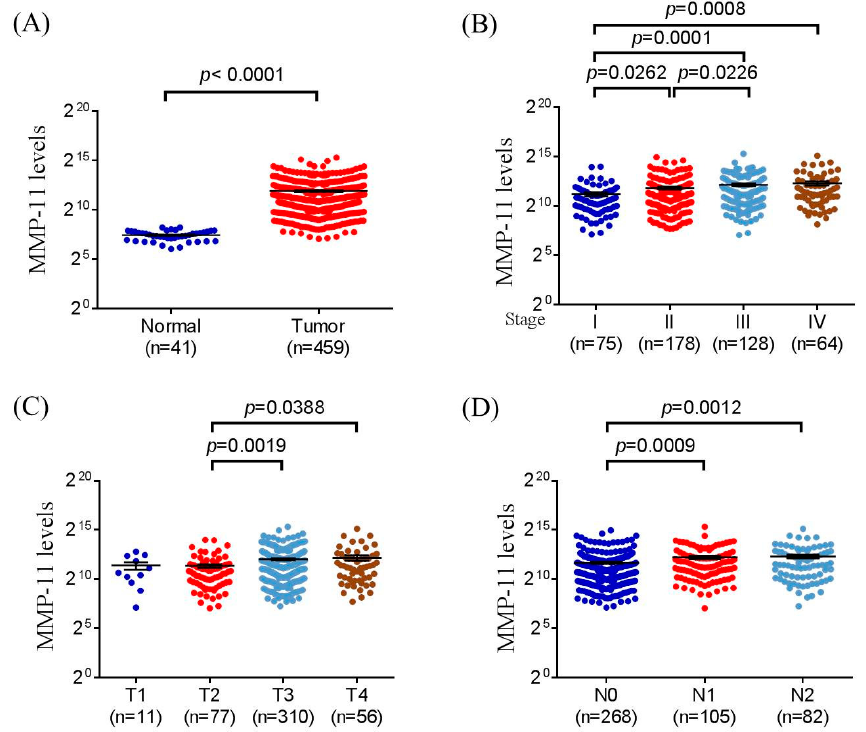
Figure 1. MMP-11 level of colorectal cancer patients from TCGA database. ( A ) MMP-11 levels were compared between the colorectal cancer tumor tissues and normal tissue. ( B ) MMP-11 levels were compared between stage I + II and stage III + IV. ( C ) MMP-11 levels were compared between the T1 + T2 stage and T3 + T4 stage. ( D ) MMP-11 levels were compared between the N0 stage and N1 stage.